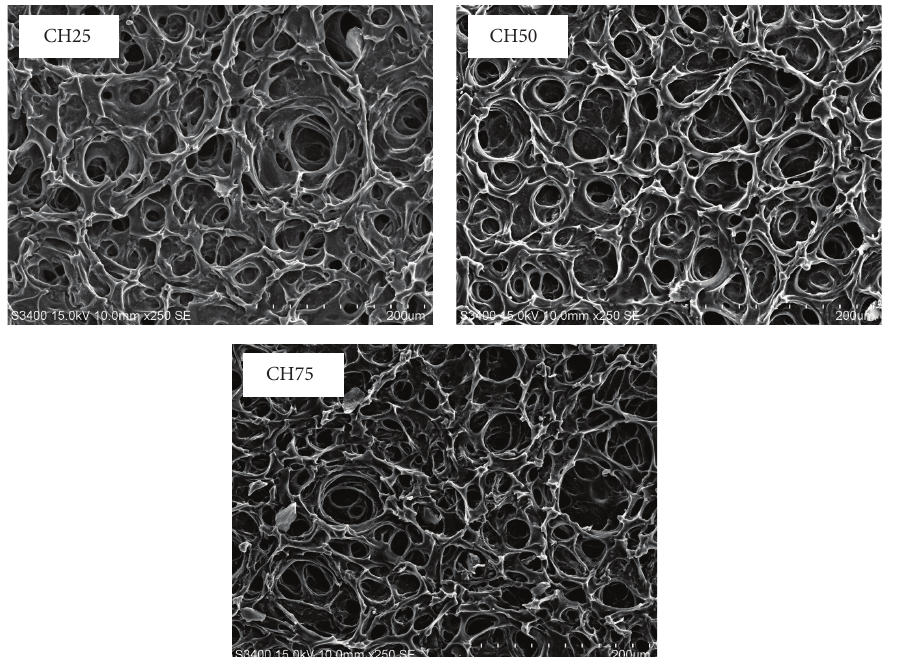
Figure 2: SEM image of various grafted PVA-g-chitosan 3D scaffolds. (Chitosan ratio: CH25 is 0.25 g, CH50 is 0.50 g, and CH75 is 0.75 g.)